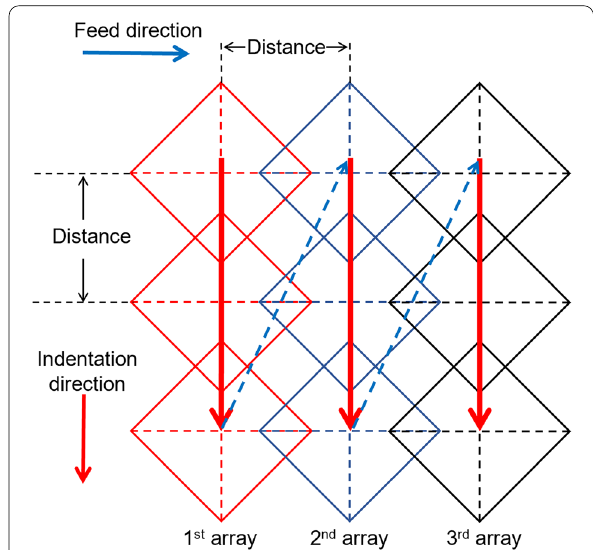
Figure 14 Schematic of machining procedure of the arrays of indentations